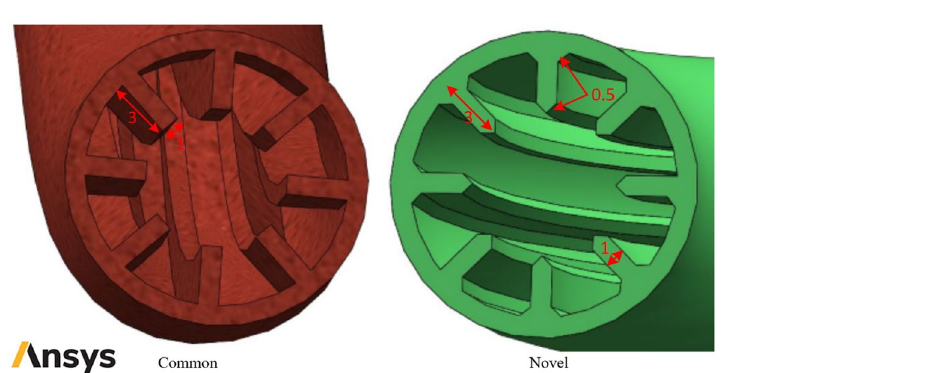
Figure 3. Schematic diagram of studied helical heat exchanger with different turbulators (Images used courtesy of ANSYS,